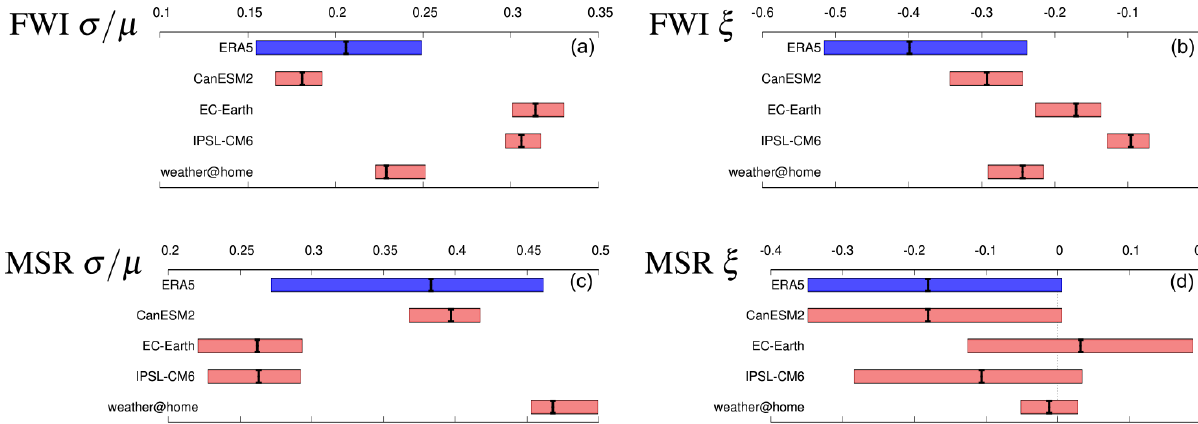
Figure 5. Model verification for the FWI (a, b) and MSR (b, c) . The left figures show the dispersion parameter σ/µ , and the right figures show the shape parameter ξ . The bars denote the 95% uncertainty ranges.